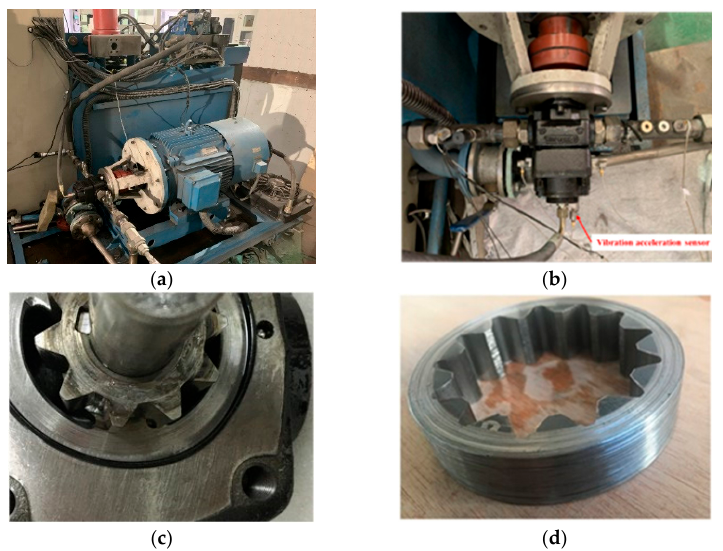
Figure 5. Accelerated life testing process. ( a ) Test setup. ( b ) sensor placement. ( c ) gear wear. ( d ) gear ring wear.